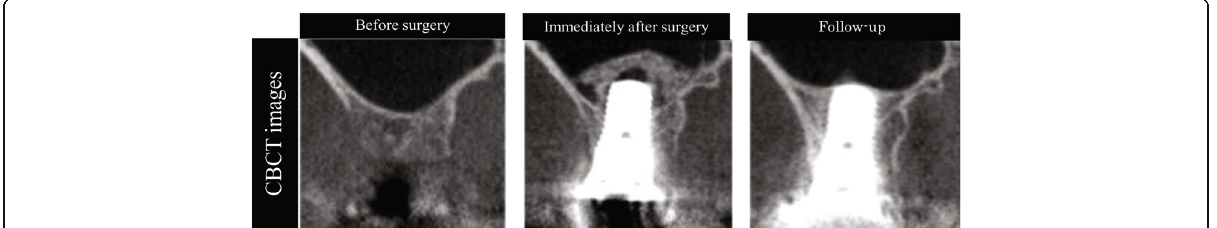
Fig. 1 Treatment protocol for the present study. CBCT was performed before surgery, immediately after surgery, and at follow-up ( ≥ 3 years). CBCT, cone-beam computed